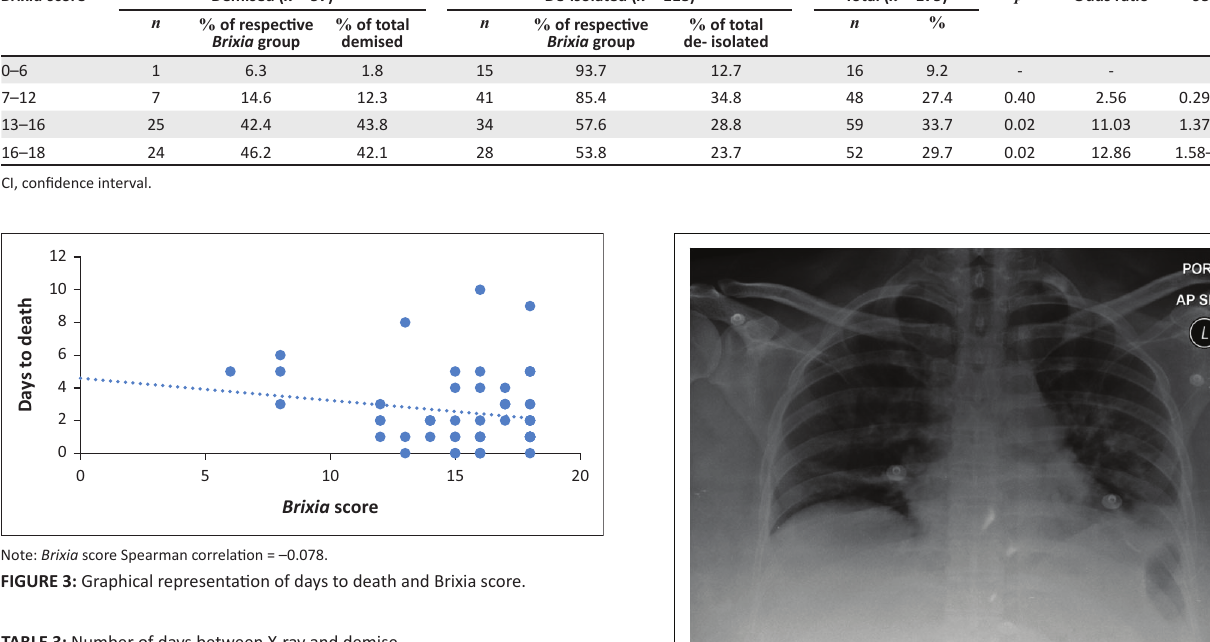
TABLE 2: Summary of outcomes data and severity index using the Brixia scoring system. Brixia score